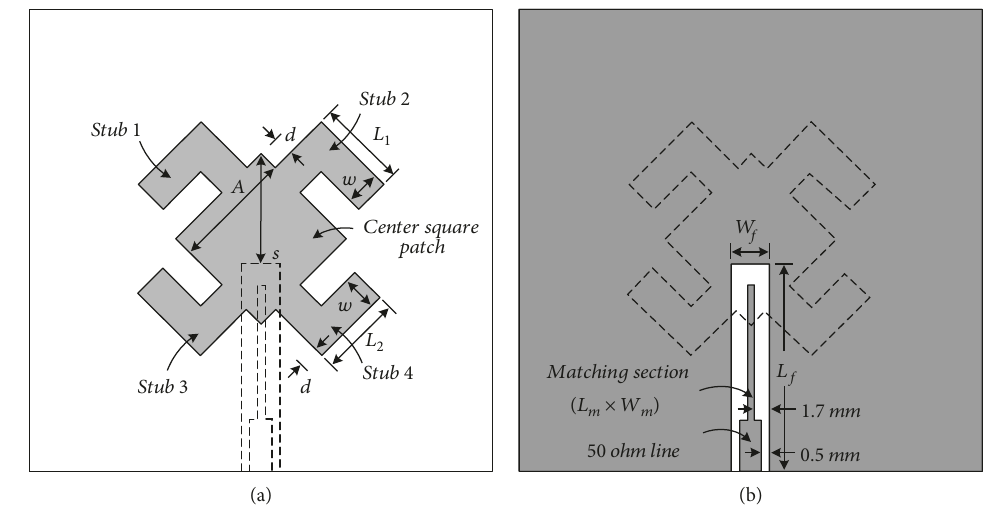
Figure 1: Proposed circularly polarized antenna: (a) top layer and (b) bottom layer viewed from above.